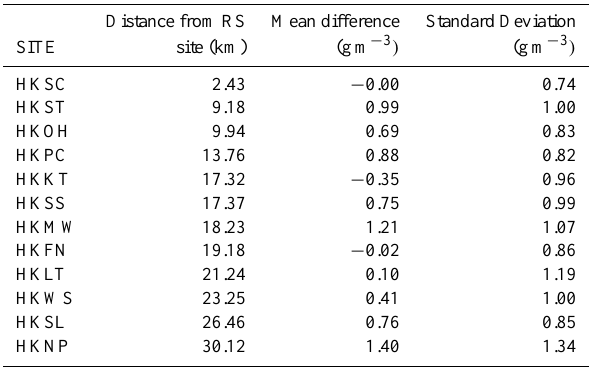
Table 2. Divided surface humidity measurements at HKSC site us- ing different basis of classification and their comparison with ra- diosonde